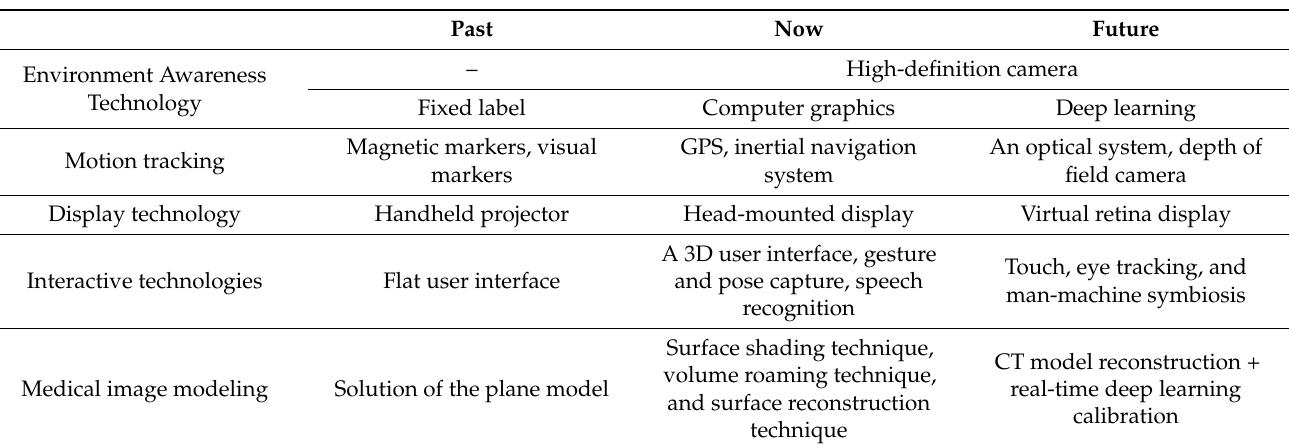
Table 1. XRSG technology in the